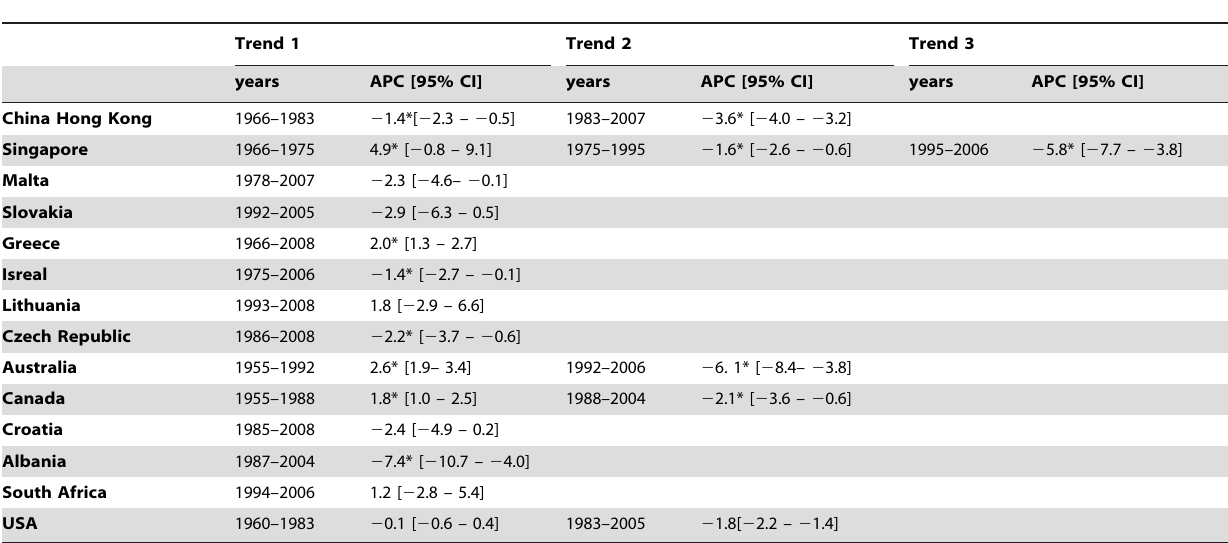
Table 2. NPC mortality rate trends in population older than 30 years with Joinpoint analyses on the available data of the 14 out of the top 20 mortality rate